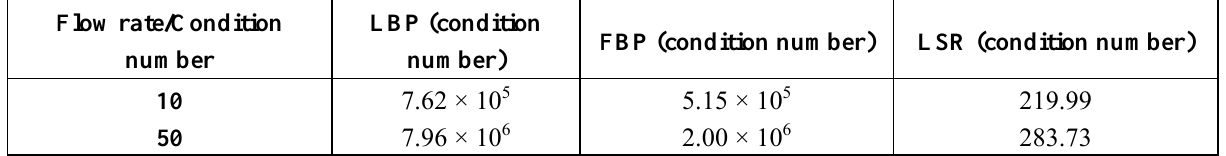
Table 2. Images condition number for two types of